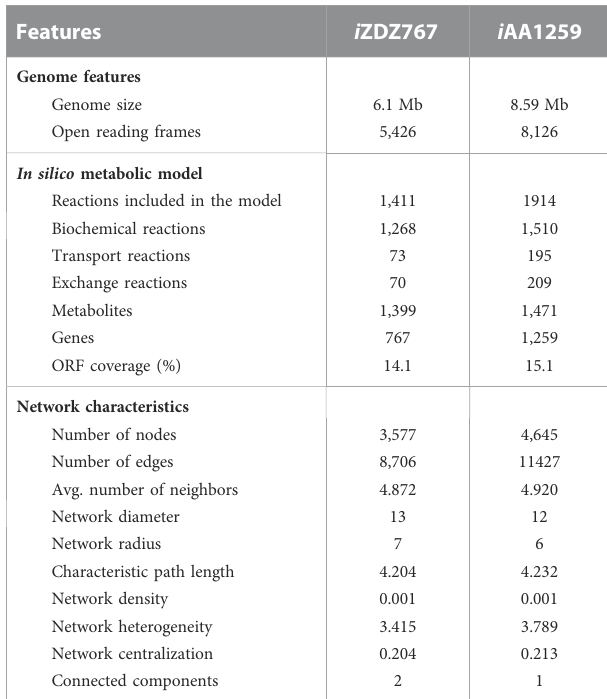
TABLE 1 The characteristic of model i ZDZ767.